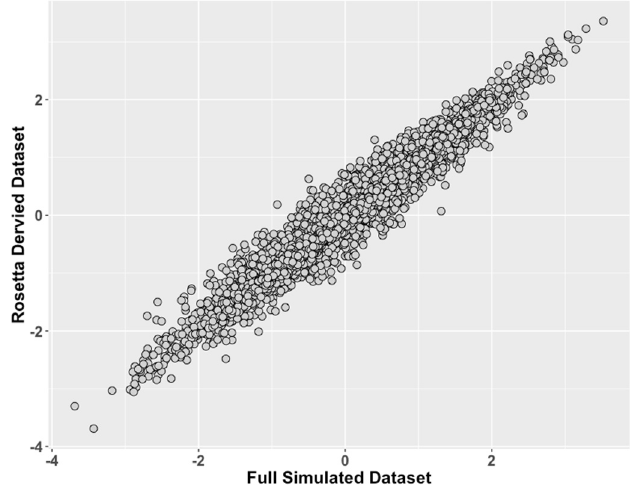
Figure 2. Study 1: Comparison of ROSETTA trait scores on incomplete data versus latent trait scores on complete data. We compared values of the latent traits from the full dataset condition (ground truth) on the x-axis to the incomplete matched datasets derived with ROSETTA on the y-axis.